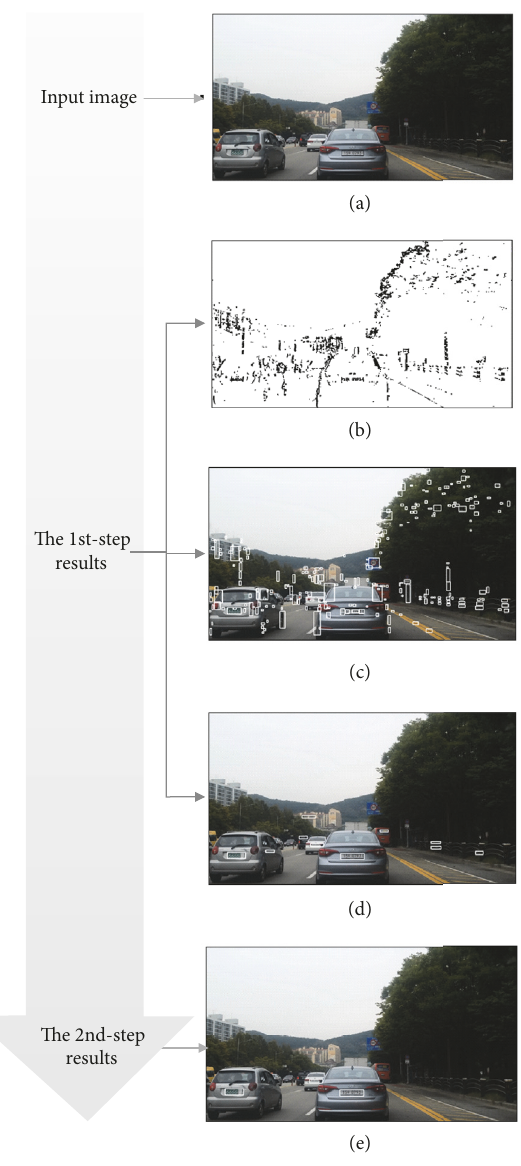
Figure 2: The processing sequence of the proposed